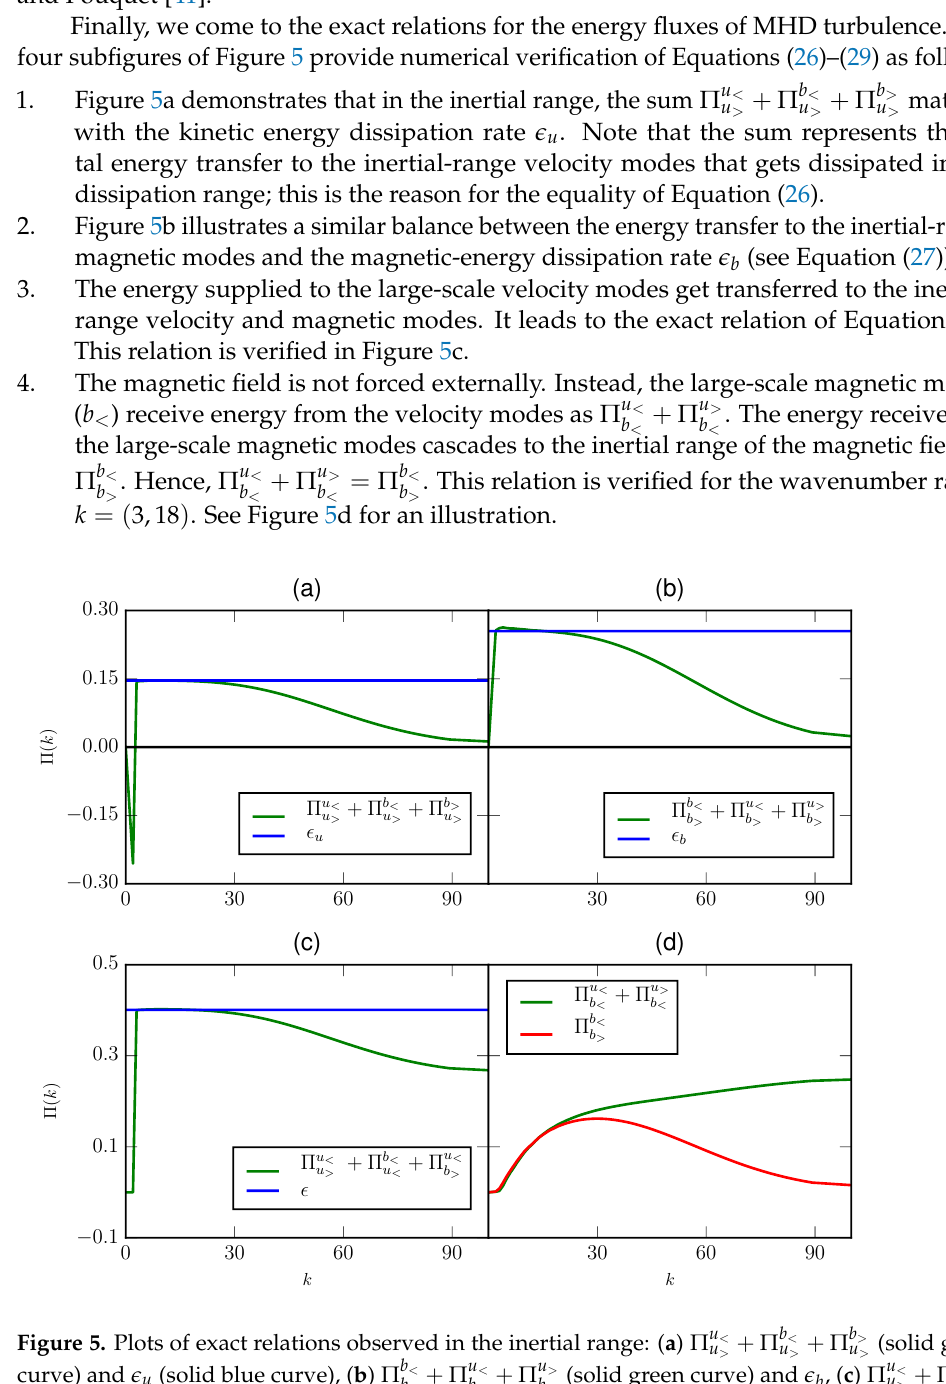
Figure 5. Plots of exact relations observed in the inertial range: ( a ) Π u < u curve) and (cid:101) u (solid blue curve), ( b ) Π b < Π u < (solid green curve) and (cid:101) = (cid:101) u + (cid:101) b (solid blue curve) and ( d ) Π u < b > and Π b < (solid red curve). The results are averaged over time frame t = b >